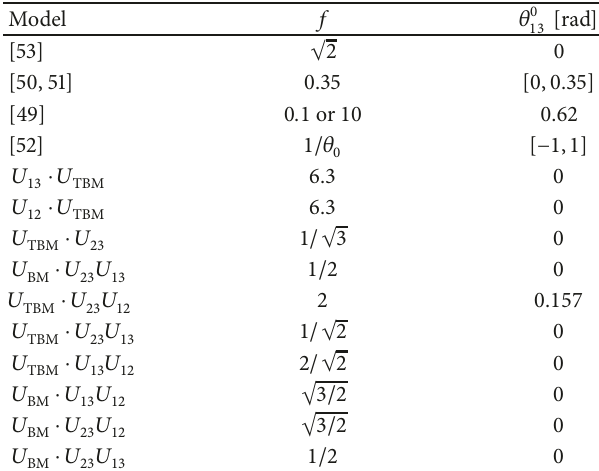
Table 4: Summary of models containing reactor and atmospheric angle correlation. All the possible combinations of corrections from tri-bimaximal, bimaximal, and democratic mixing were considered in [111].